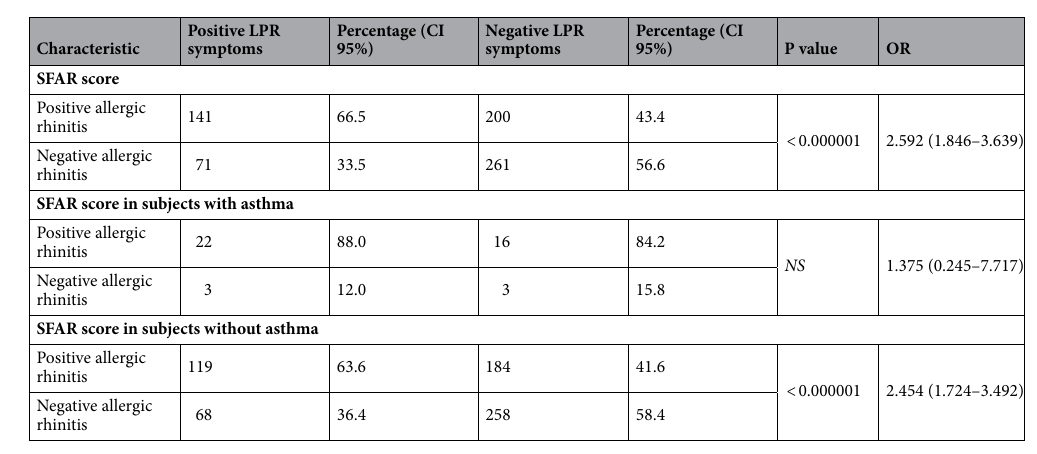
Table 2. Comparing positive SFAR score with positive RSI score. CI: Confidence interval; SFAR: Score for allergic rhinitis; RSI: Reflux symptom index; OR: Odds ratio; NS: Not significant. Chi-square was used to determine the significance of the comparisons in this table.